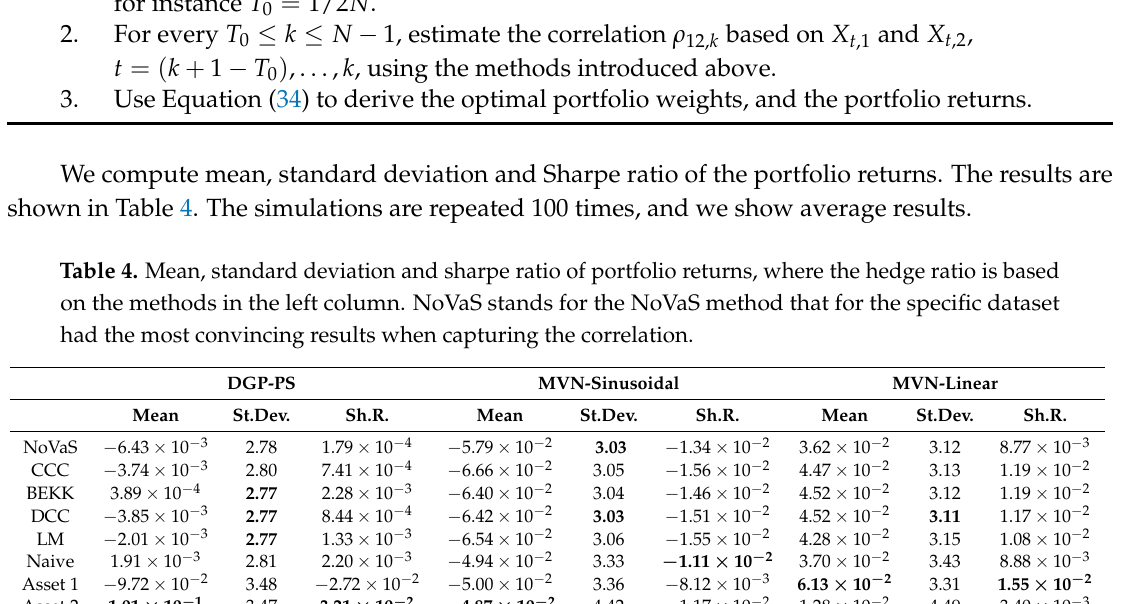
Table 4 confirms previous results. NoVaS is on structured simulated data not able to outperform known methods based on multivariate GARCH. However, especially when looking at the